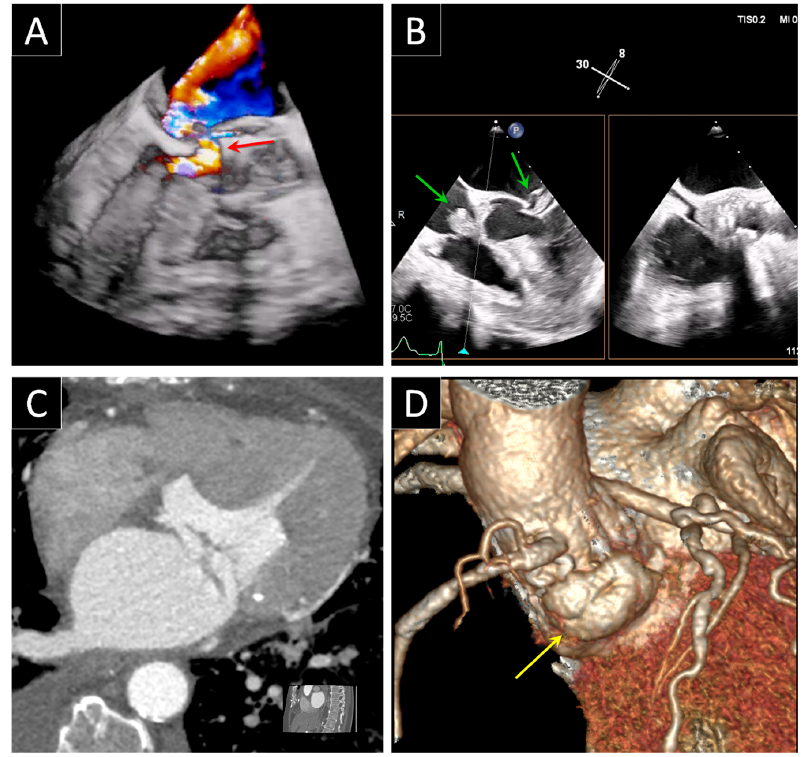
Figure 6. Bioprosthetic aortic valve abscess. ( A ) Standard 3D TEE merged with color demonstrating the presence of the PVL associated with the disruption of the mitral-aortic junction (red arrow) in a patient with infective endocarditis. ( B ) Vegetations are clearly visible on the tricuspid valve and mitral valve leaflets (green arrows) using 2D TEE x-plane view ( C ) CT image and ( D ) 3D CT reconstruction showing the abscess (yellow arrow) at the level of mitral-aortic junction.